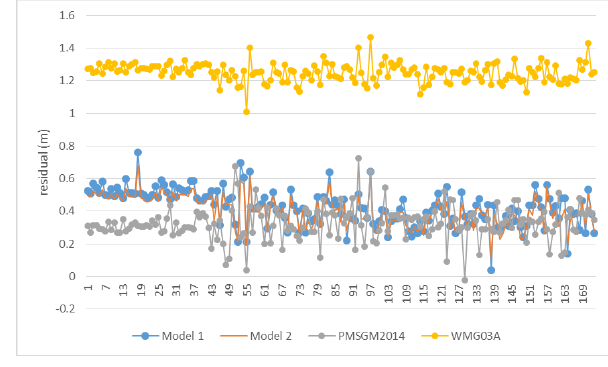
Figure 12 The difference between four gravimetric geoid and 173 GNSS leveling (Unit: m) Table 4 RMSE before and after fitting to MSL (Unit: